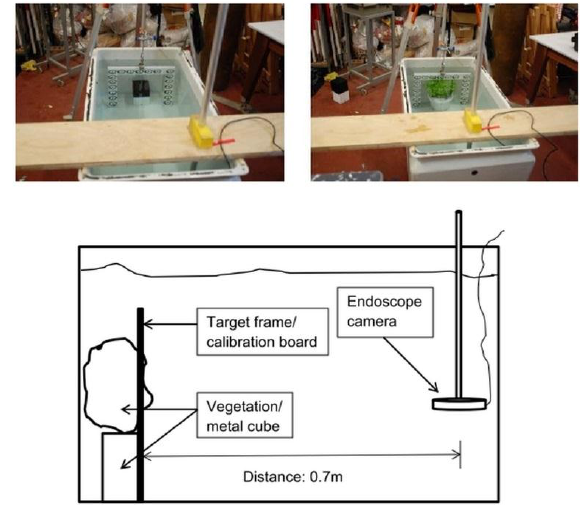
Figure 3. Plastic water tank setup.